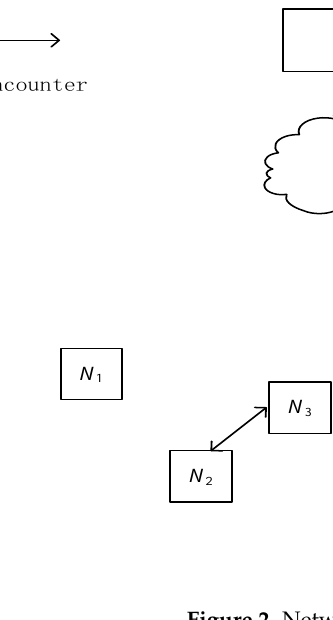
Figure 2. Network Figure 2. Network model.